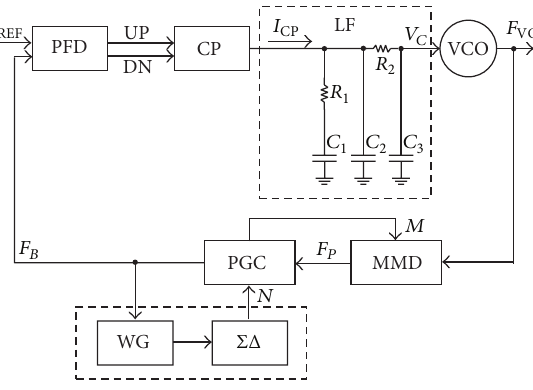
Figure 3: Conventional SSCG block